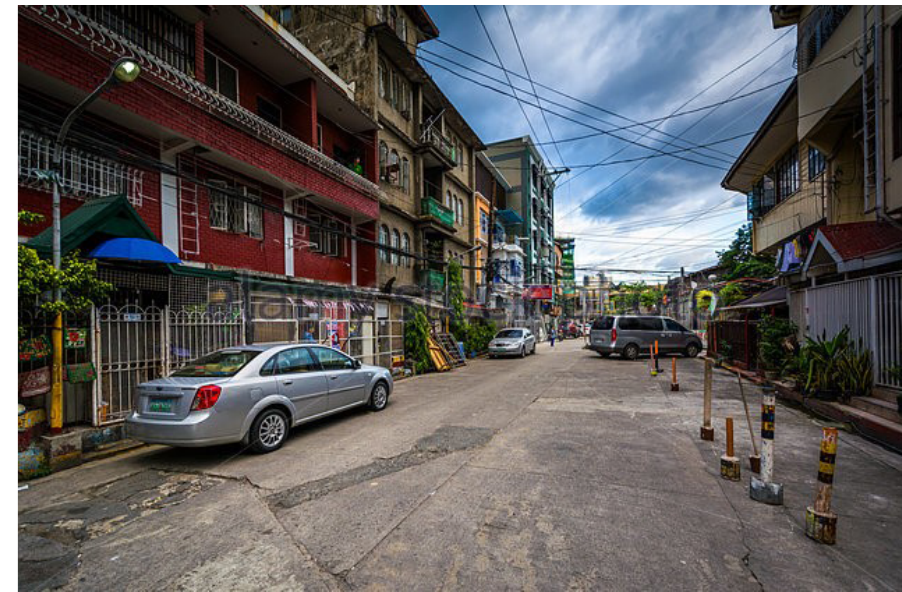
Figure 4. Low income neighbourhood in Sampaloc District (Source: Dreamstime,